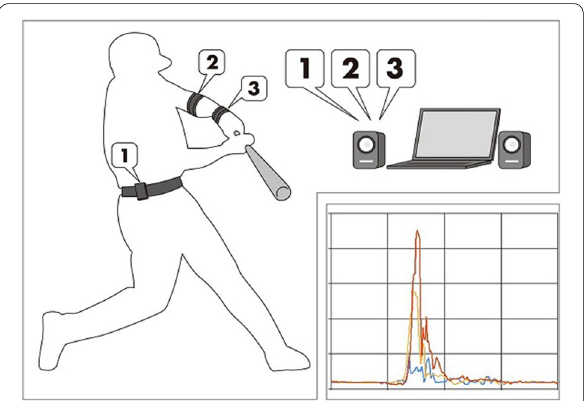
Fig. 2 Overview of the auditory cue biofeedback